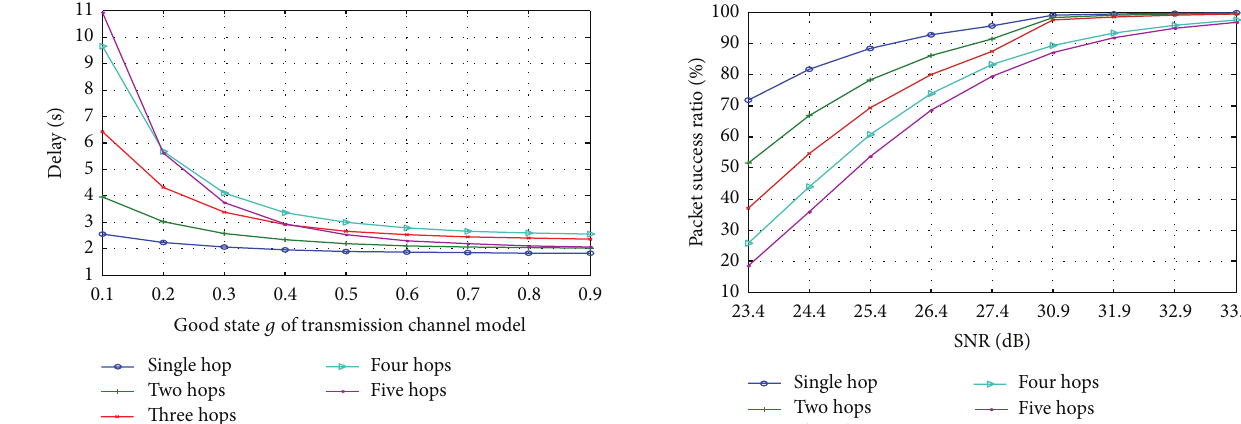
the power consumption and the average end-to-end delay is impacted by the number of selected multipaths, which reveals that the ECMP model uses a smaller or longer multipath resulting in lower power consumption with a higher average end-to-end delay.